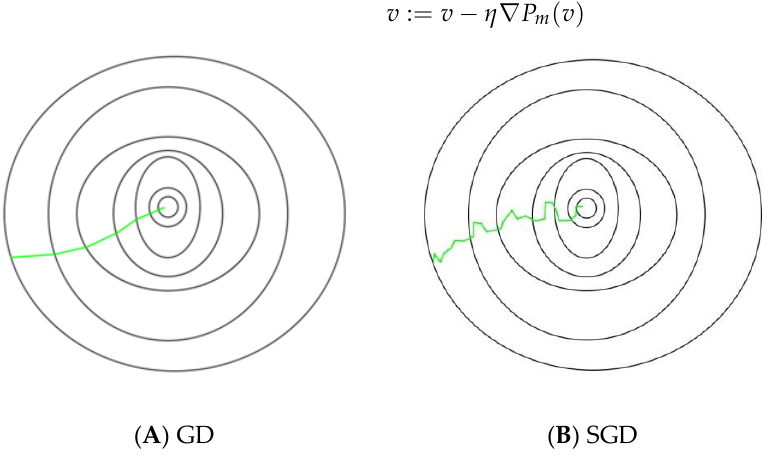
Figure 4. Path followed in GD and SGD to attain minima